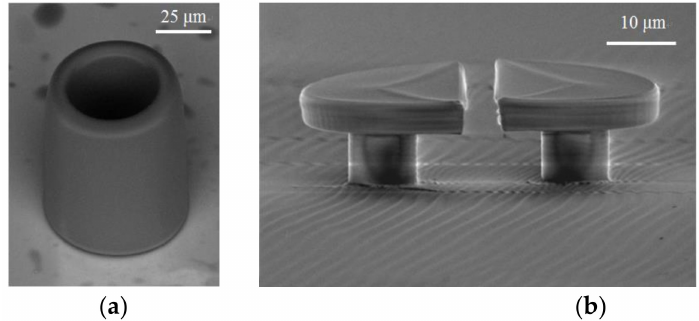
Figure 7. The SEM image of ( a ) WGM microcavity laser; and ( b ) tunable WGM laser